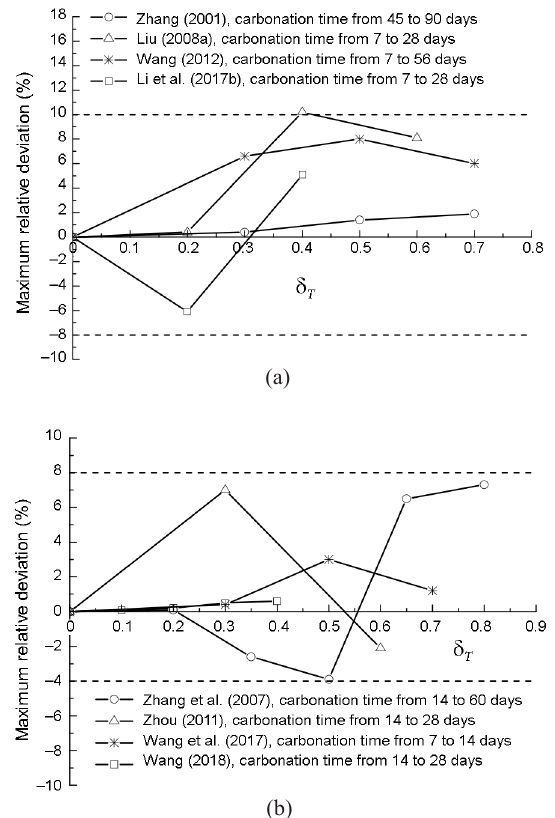
Figure 5. Influence of carbonation time on stress influence coefficient under tensile stress